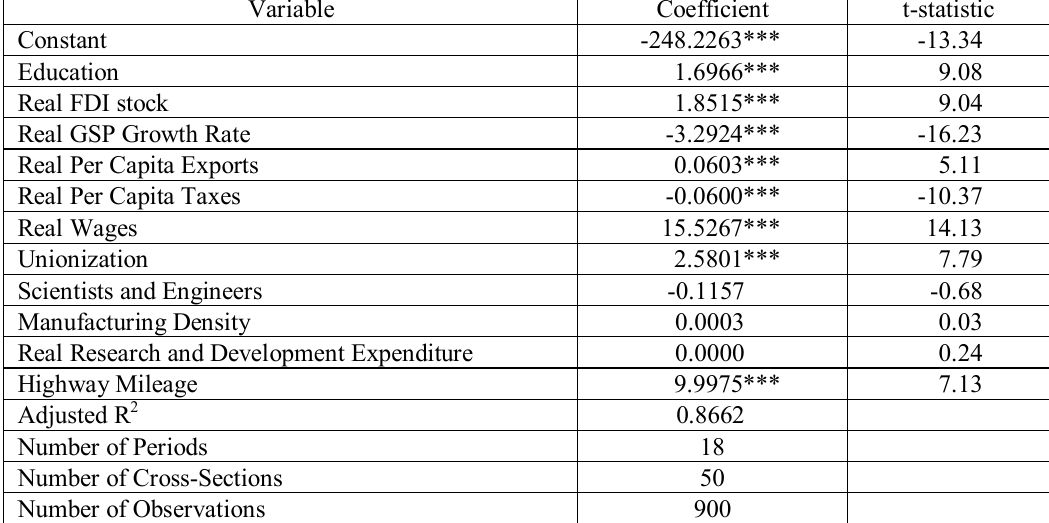
Table 3. Determinants of FDI Related Employment in the United States, 1990-2007 Panel Least Squares Estimates, Dependent variable: FDI Related Employment